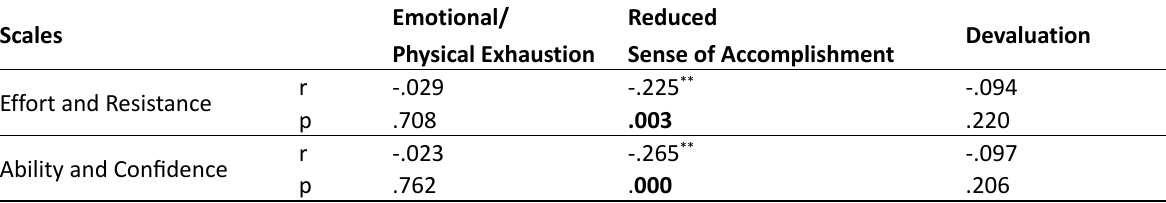
Table 8. Evaluation of the relationship between general self-efficacy and sub-dimensions of athlete burnout